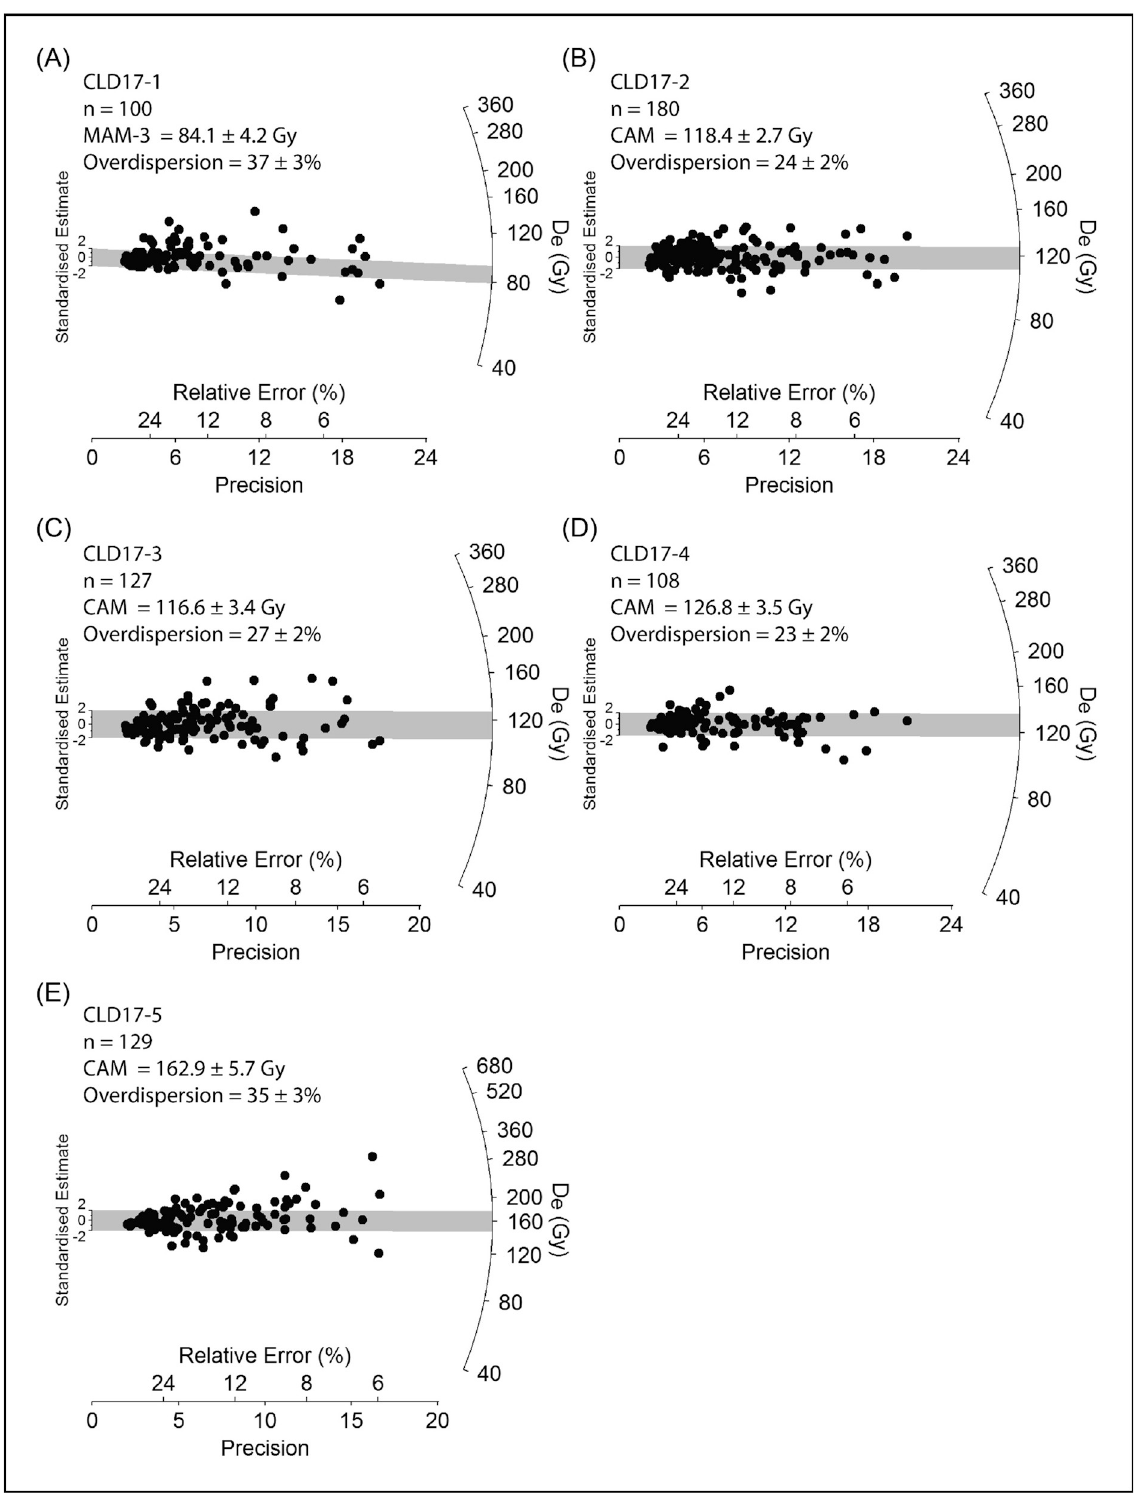
Fig 16. Radial plots showing the OSL samples’ single-grain D e distributions. The grey bar is centred on the age model that provides the optimum statistical fit for each distribution (bold values in S1D Table in S1 File).